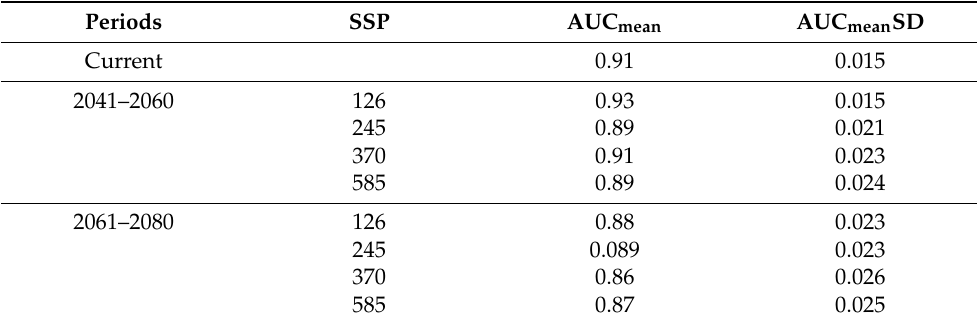
Table 1. Mean AUC values (AUCmean) and standard deviation of the mean AUC values (AUCmeanSD) for the current and future MaxEnt models for Boreal Owl’s distribution under different SSP scenarios.